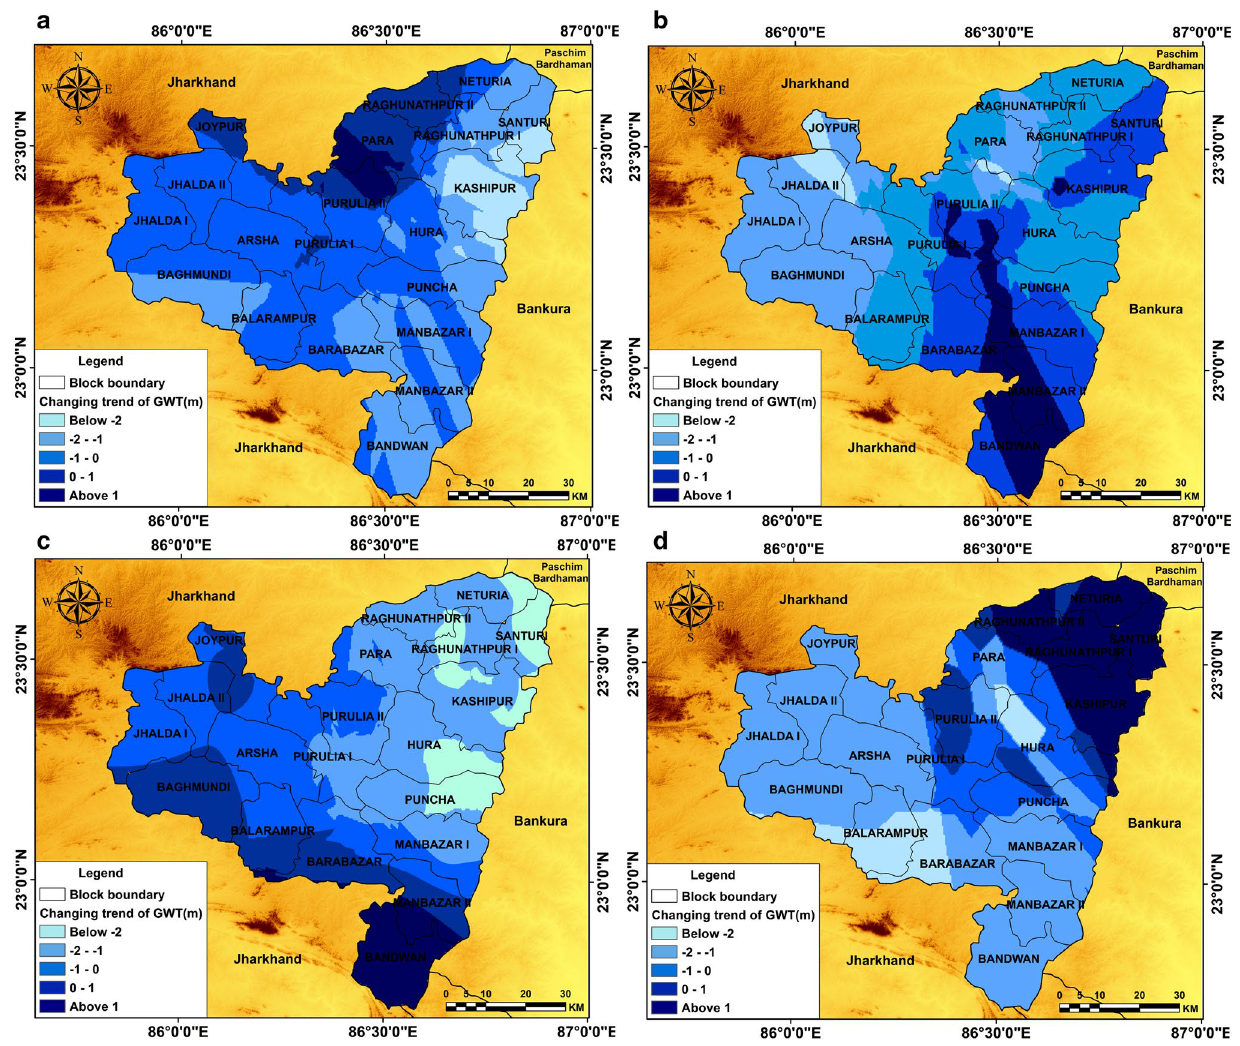
Fig. 4 Changes of groundwater height scenario at Purulia district of different years in post monsoon season, a 1996–2001, b 2001–2006,